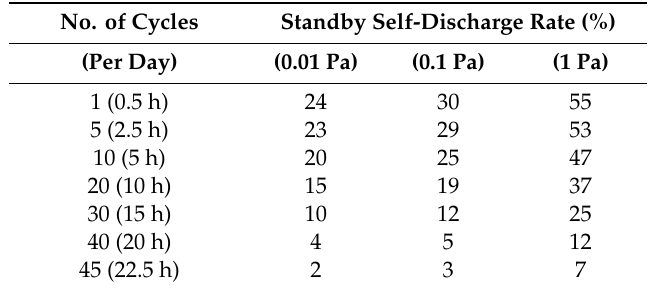
Table 6. Flywheel standby discharge rate relative to the number of cycles.